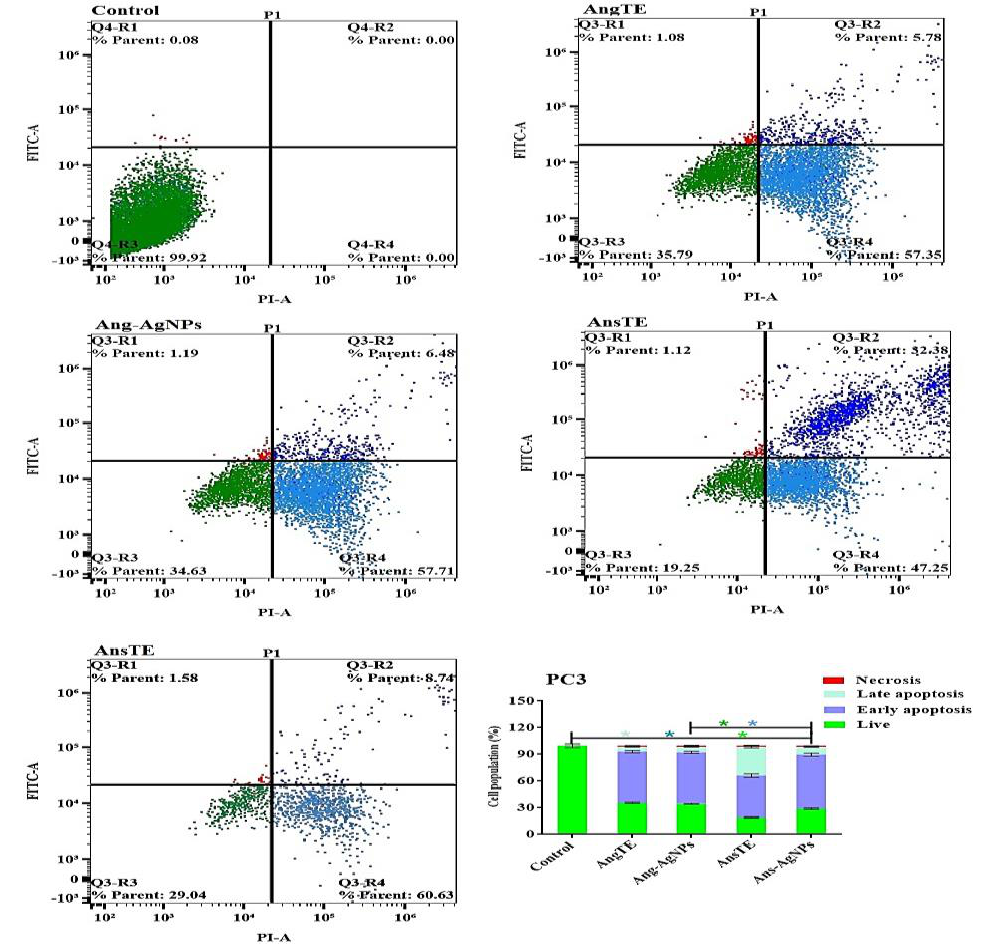
Figure 12. Apoptosis/necrosis assessment for the extracts, AngTE, AnsTE, and their nanoparticles, Ang-AgNPs, and Ans-AgNPs, respectively, against PC3 subjected to previous treatment for 48 h, and apoptosis/necrosis quantified using flow cytometry. Data are presented as the mean ± SD; n = 3 One-way ANOVA was used to test for statistical difference (* p < 0.05).